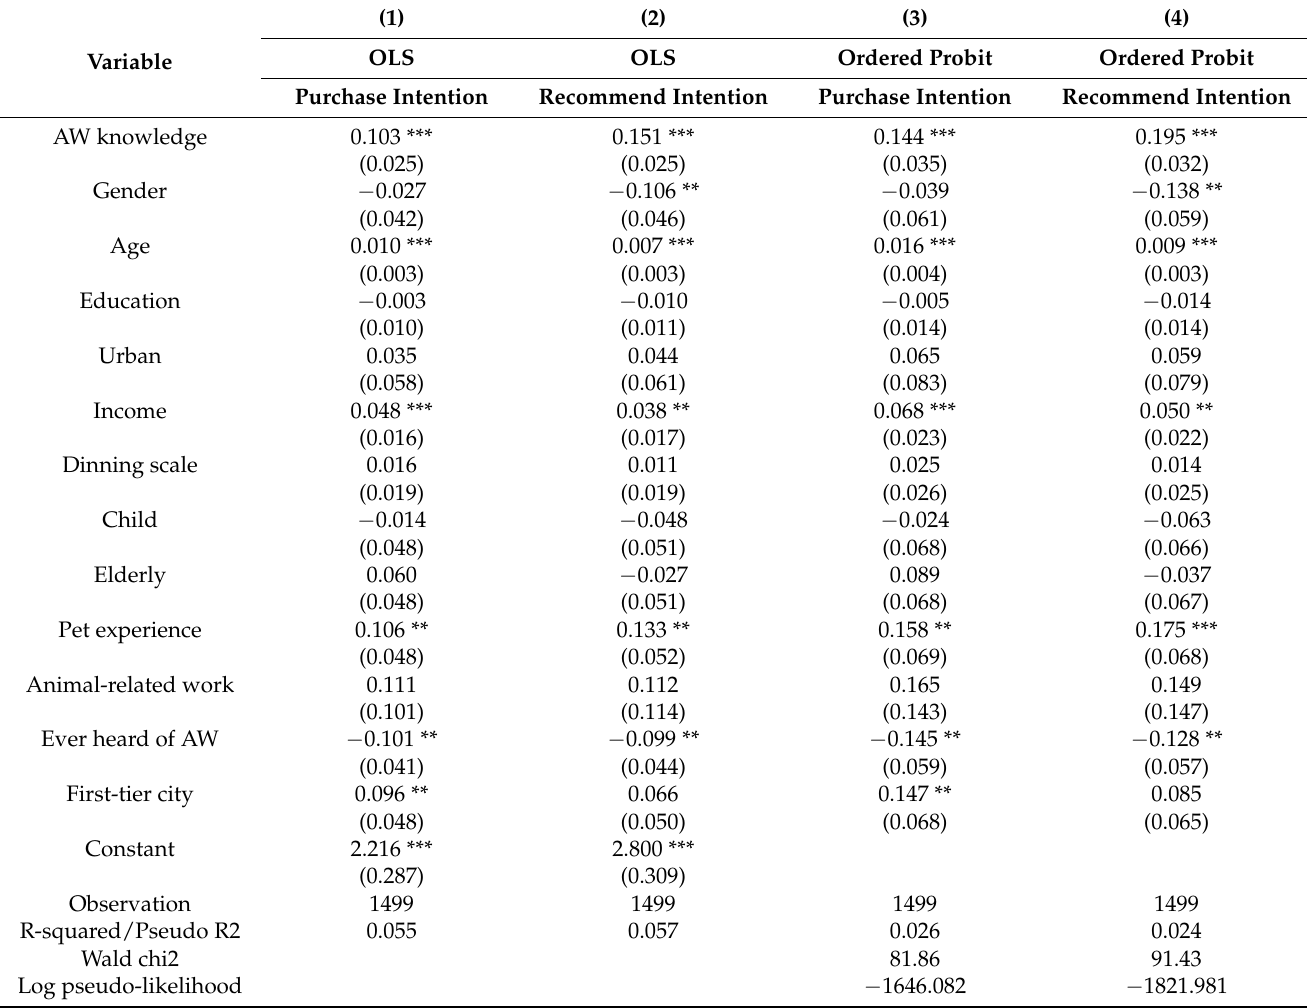
Table 6. Total effects of animal welfare knowledge on consumer’s behavioral